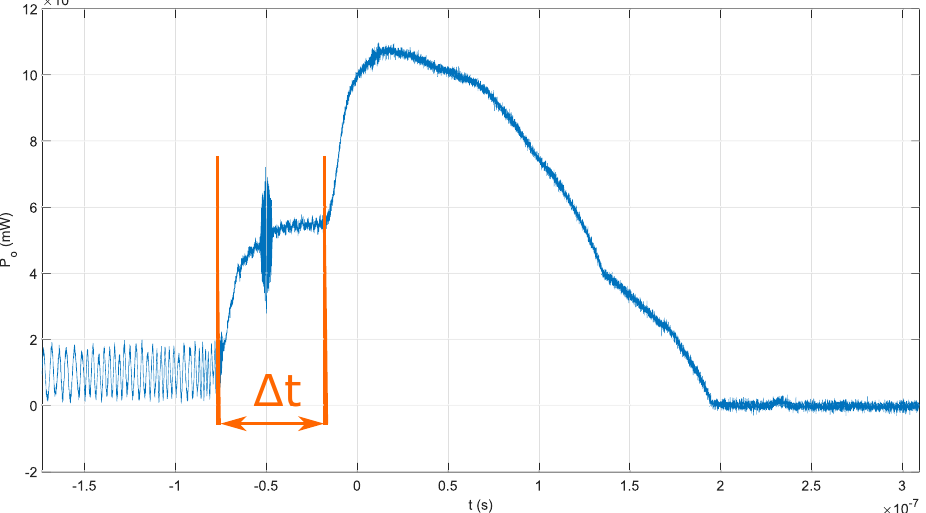
Figure 8. Generated optical signal with EDFA in the optical signal evaluation’s third experiment with visible delay t, which corresponds to the OPD ∆ L = 6